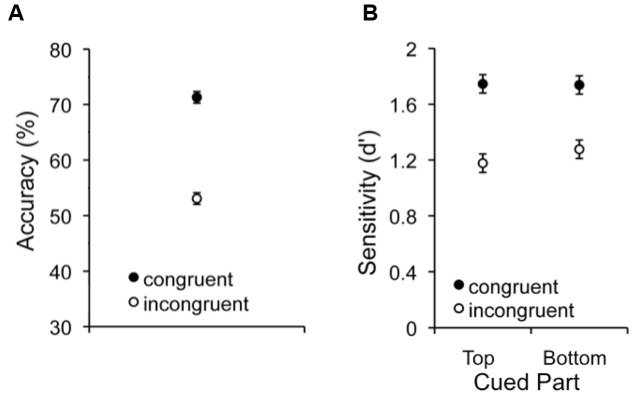
Mean performance for congruent and incongruent trials in the
(A) VHPT-F and (B) composite task. Error bars show 95% confidence intervals for within-subject effects (Loftus and Masson, 1994).